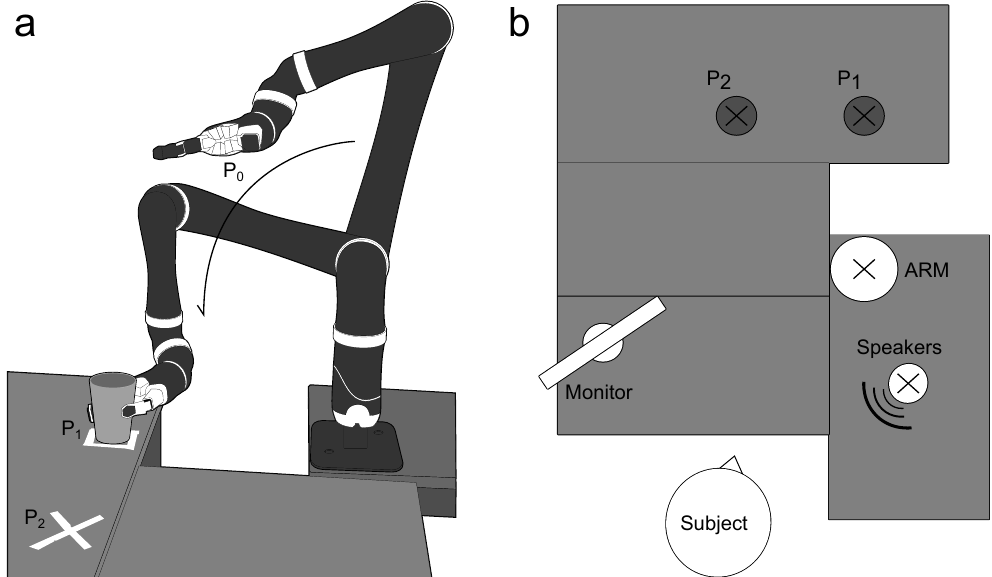
Figure 3. Experimental Setup. ( a ) Illustration of ARM performing the pick-and-drop task. The end- effector moves from the starting position, P 0 , to grasp the cup at P 1 , to drop it at P 2 . ( b ) Illustration of the experimental setup’s